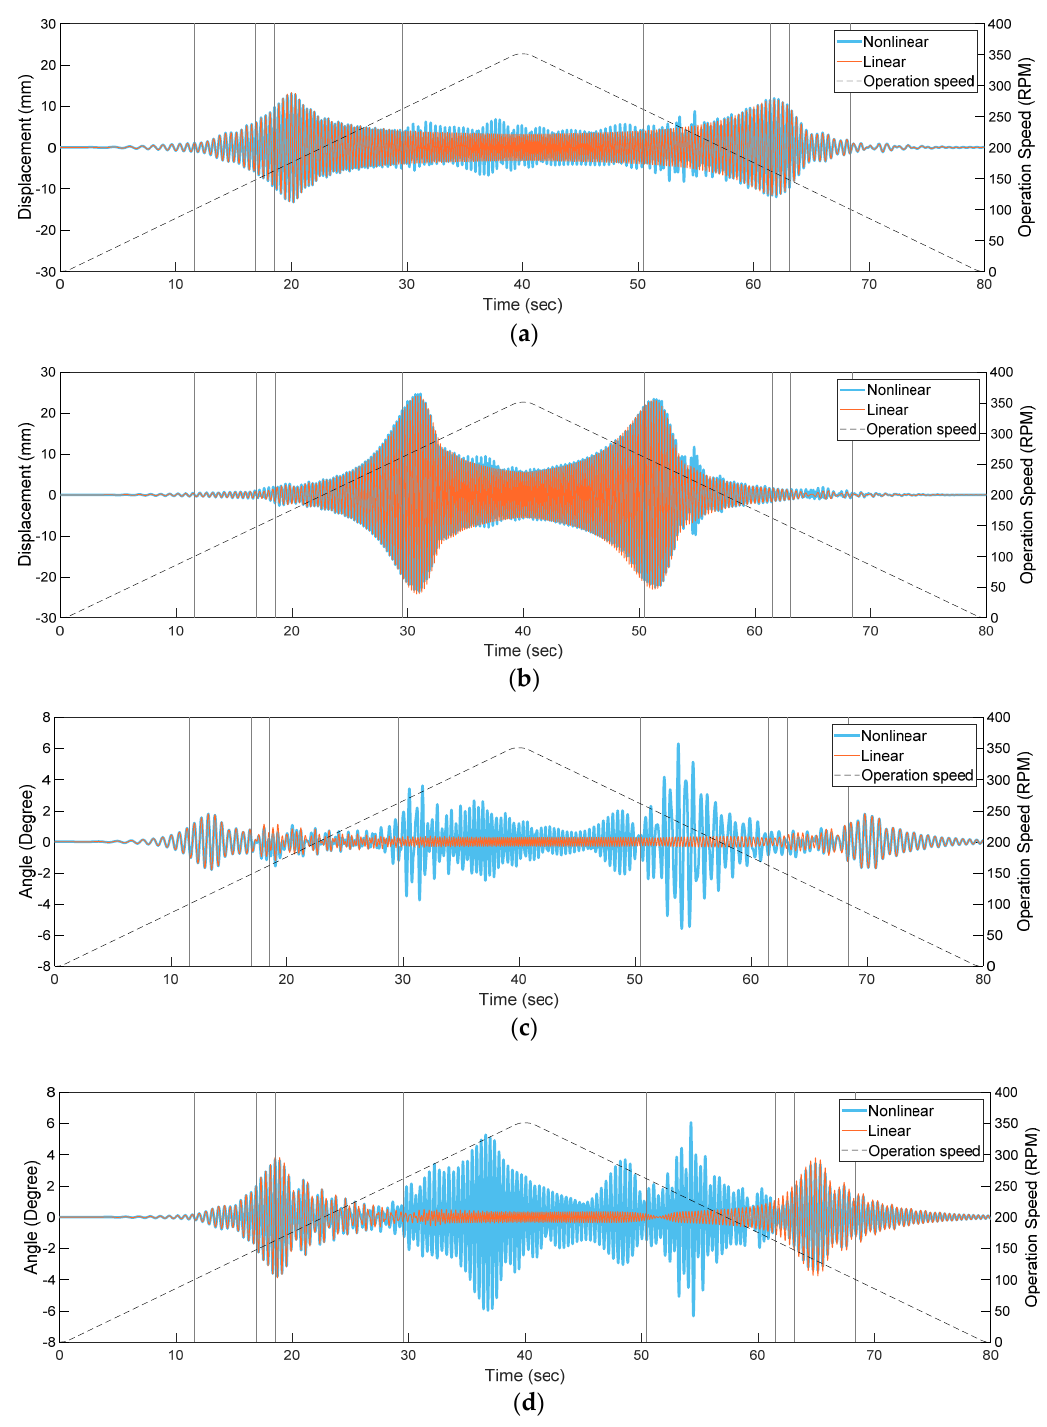
Figure 11. Comparison of the rocking angles obtained with the nonlinear and linear analytical models (when = 100 N ⋅ s/m ): ( a ) horizontal displacement of the mass center, ( b ) vertical displacement of the mass center, ( c ) rocking angle in the horizontal plane, and ( d ) rocking angle in the vertical plane.